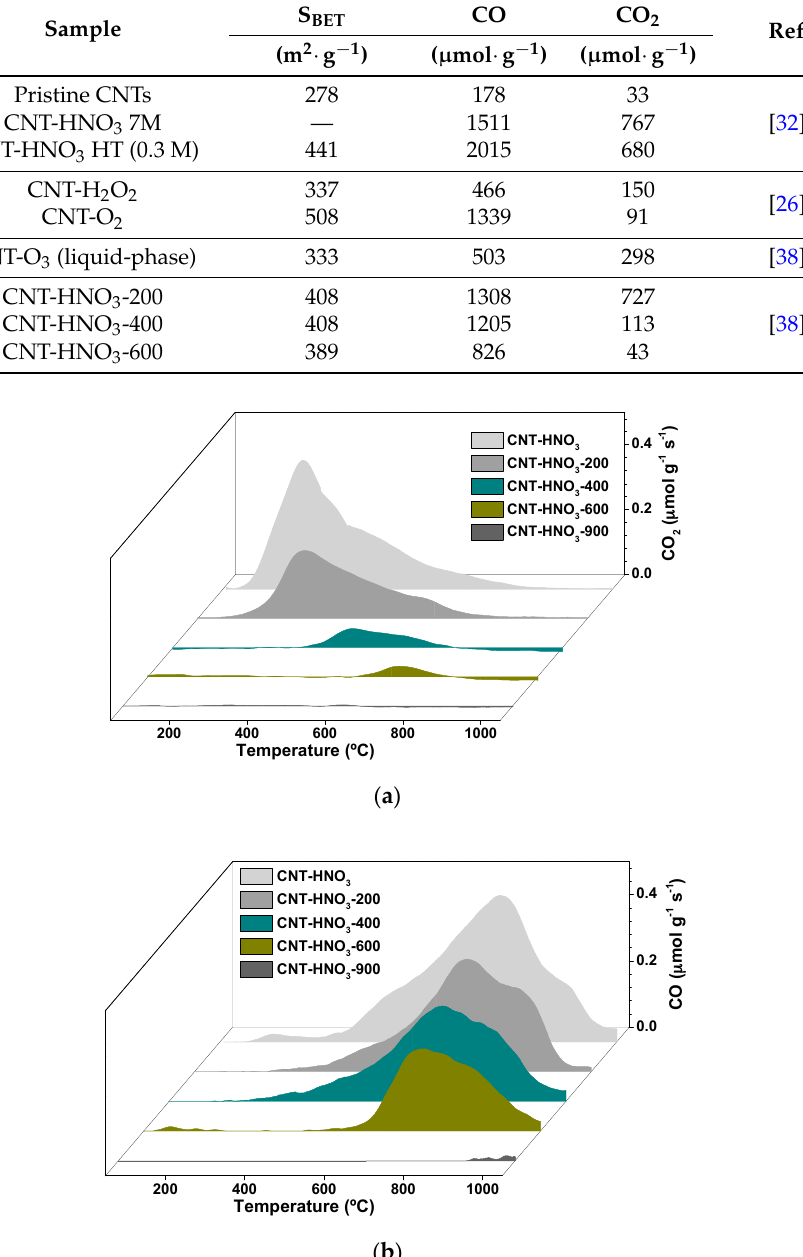
Table 1. Textural and chemical properties of modified commercial carbon nanotube (CNT) samples from the same supplier (Nanocyl NC3100).